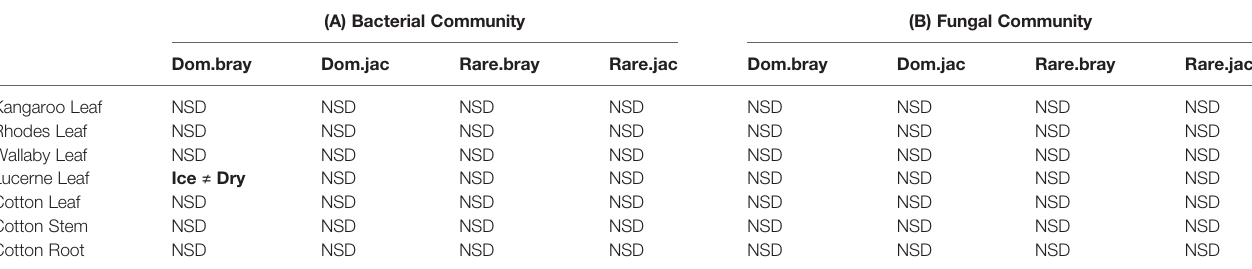
TABLE 2 | Pairwise PERMANOVA analyses of dominant and rare bacterial (A) and fungal (B) communities based on Bray – Curtis and Jaccard measures of square-root transformed relative abundances of plant bacterial communities under different treatments (snap frozen, ice incubation and air dry).